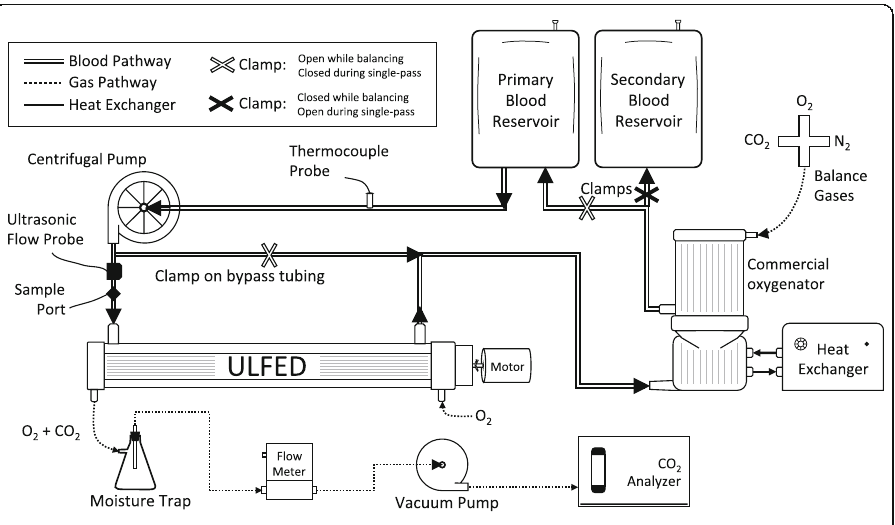
Fig. 3 Recirculating blood loop used to evaluate in vitro gas exchange